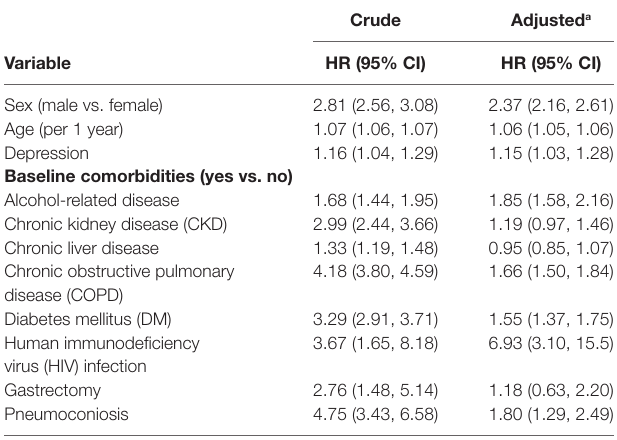
TaBle 3 | Cox model measured hazard ratio (HR) and 95% confidence interval (CI) of pulmonary tuberculosis (TB) associated with depression and comorbidities.